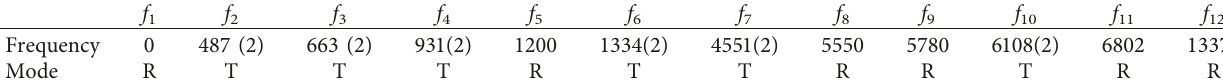
Table 2: Natural frequencies (Hz) and vibration modes of the example PGT.